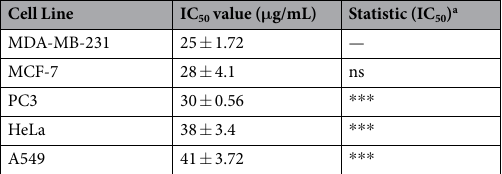
Table 1. IC 50 value of γ CdcPLI in different cell cancer line. a Compared with IC 50 value of MDA-MB-231 ( *** p <